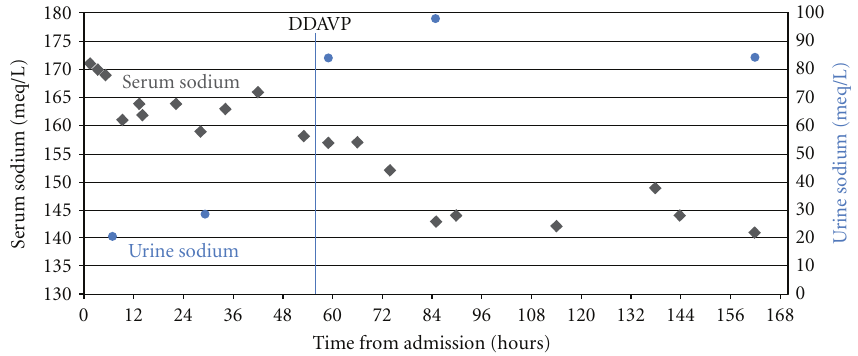
Figure 1: Serum and urine sodium before and after DDAVP administration.